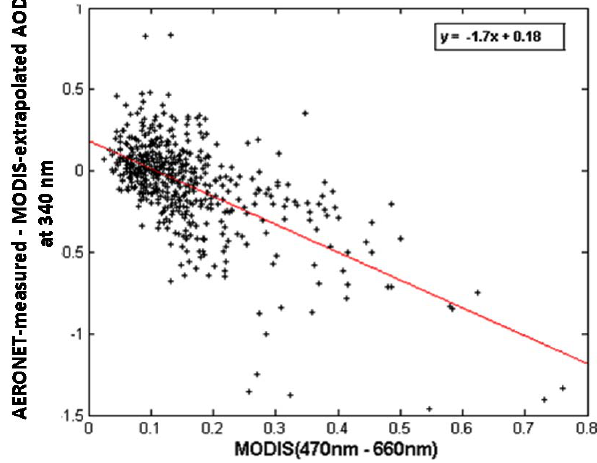
Fig. 1. MODIS-extrapolated AOD at 340nm versus AERONET- measured values.